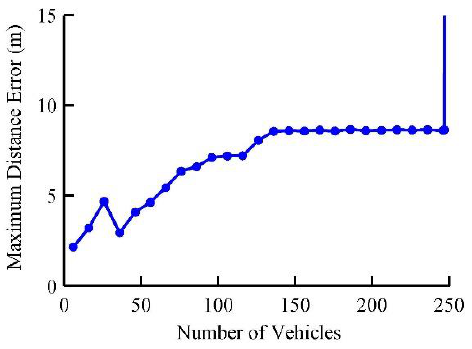
Figure 9. Influence analysis of platoon length.